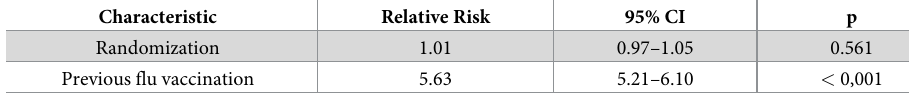
Table 3. Factors associated with increased vaccinations. October 2014—February